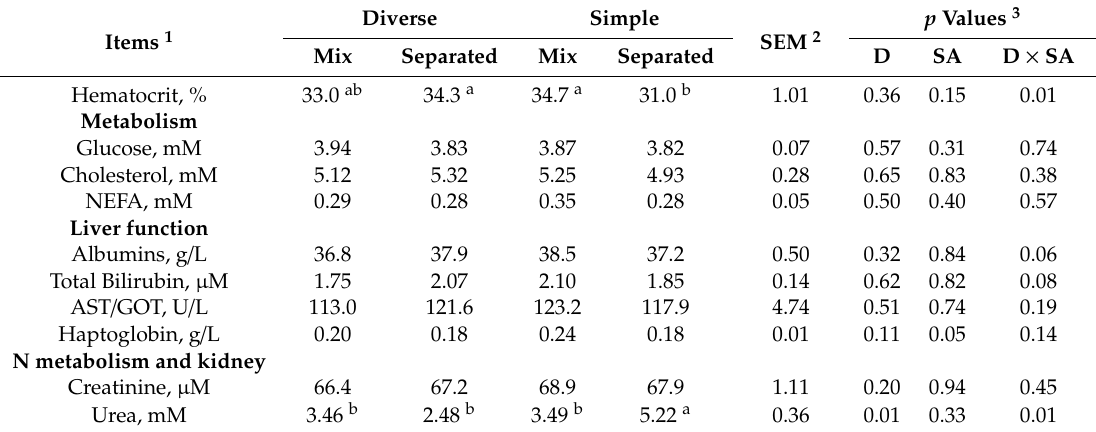
Table 7. E ff ect of pasture diversity (diverse or simple) and spatial arrangement (mix or separated) on blood parameters of dairy cows.